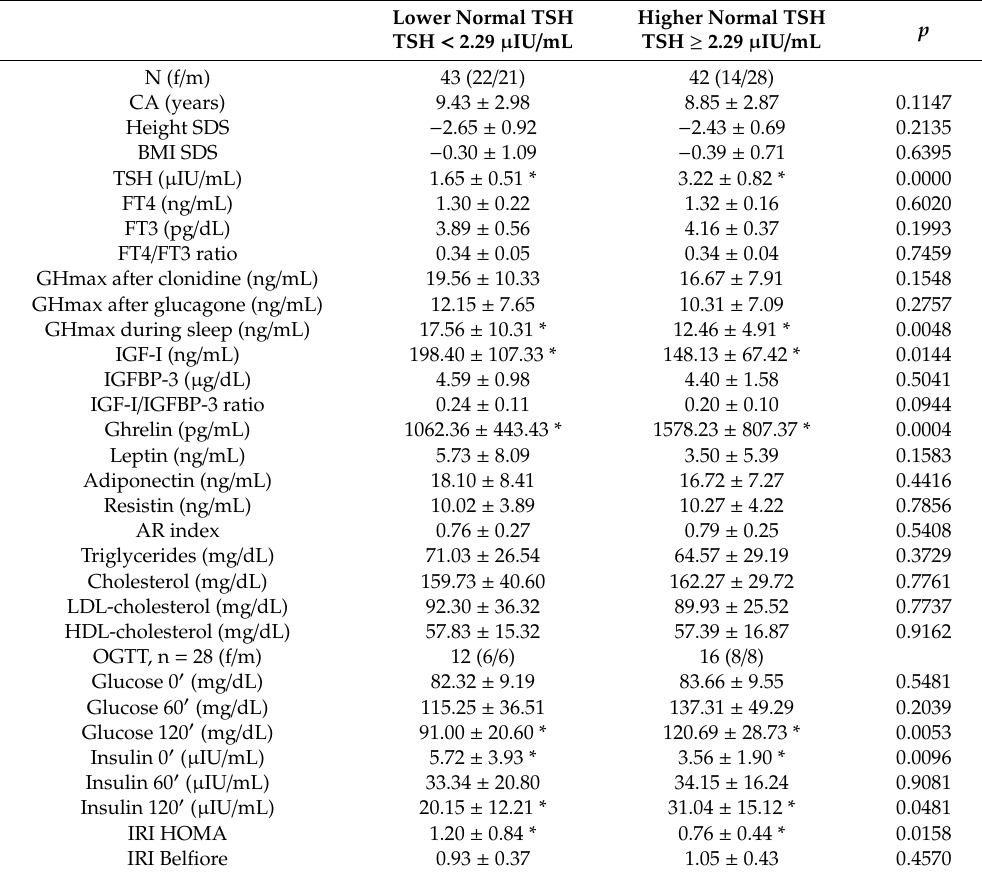
Table 1. The auxologic and biochemical parameters in children with ISS, divided into two (2) groups distinguished by dependence on TSH concentration result: first one higher than or equal to the median value - 2.29 µ IU / mL and second lower than 2.29 µ IU /